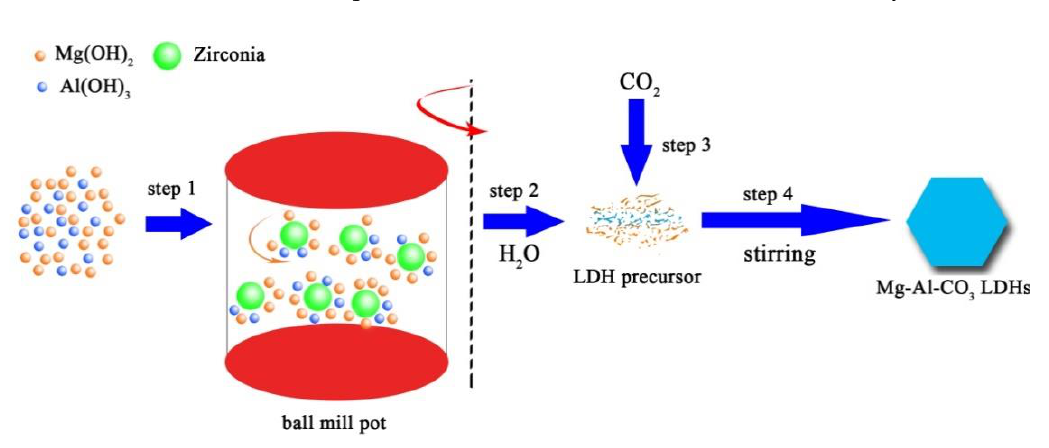
Figure 6. Schematic diagram of mechanochemical preparation method of Mg 2 Al-CO 3 LDHs.